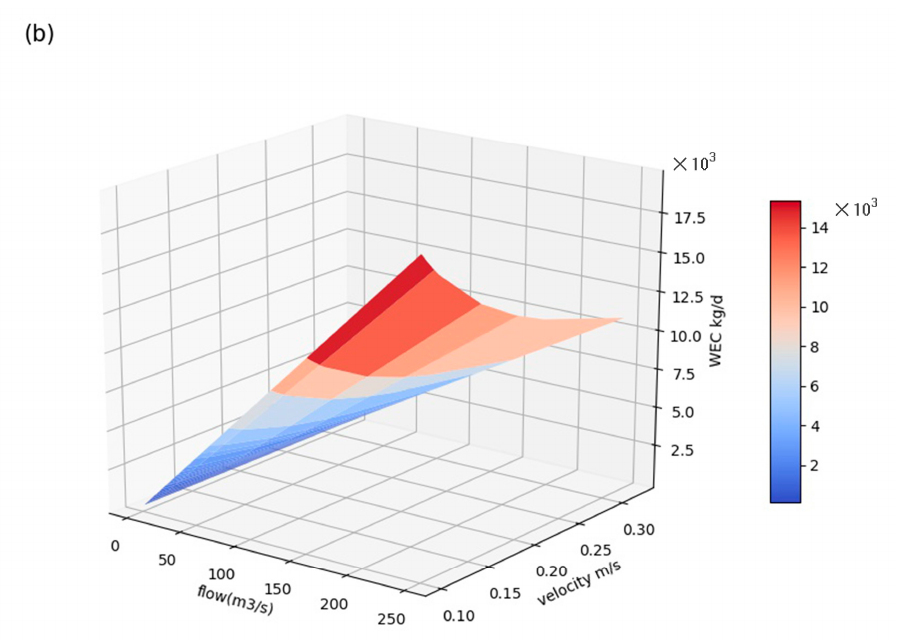
Figure 9. Response surfaces of WECs to ( a ) flow rate and water temperature and ( b ) flow rate and velocity under 20.